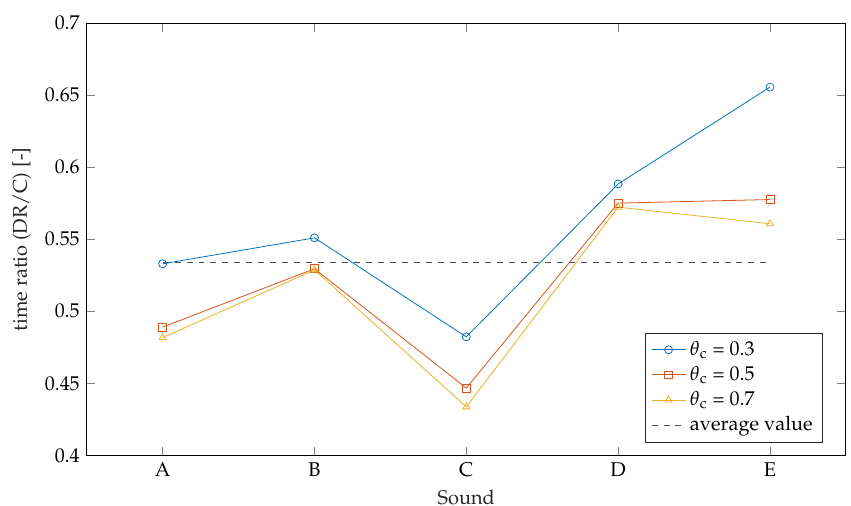
Figure 4. Relative elapsed time, Douglas–Rachford versus Condat algorithm, for all testing sounds and clipping thresholds. Both algorithms were first let to fully converge, which was in practice observed after 3000 iterations. Then, both algorithms ran again until the objective function differed by 0.1% from the respective solutions. The Gabor transform with 1024-sample long Hann window and 1024 frequency channels with 75% overlap was used.